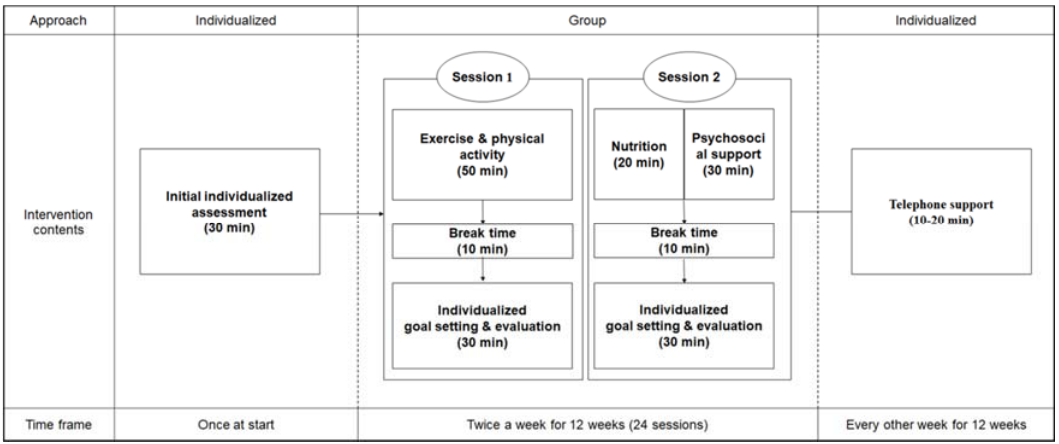
Figure 3. Program construct of the person ‐ centered nursing intervention program for frailty (PNIF).